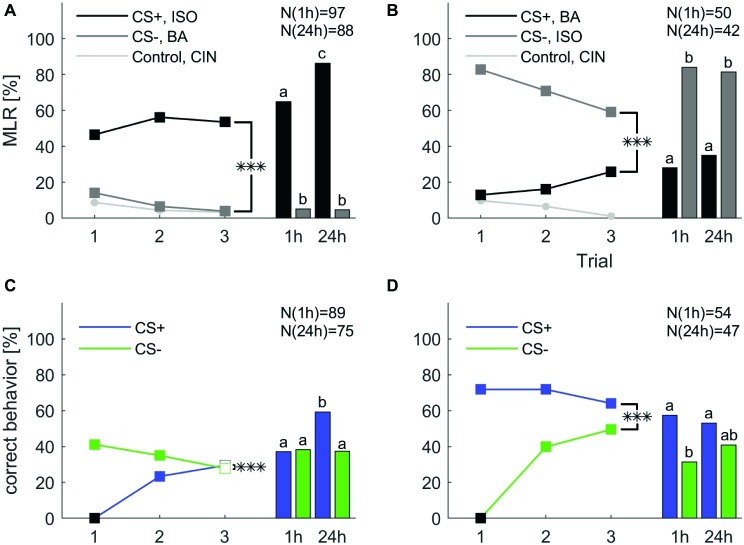
Classical olfactory conditioning over three trials with memory retention tests after 1 and 24 h. Filled squares indicate trials in which a significant difference was found between CS+ and CS− (χ2 test). Asterisks indicate a significant treatment × trial interaction (***: p < 0.001). Letters above the bars indicate significant differences between retention tests (χ2). (A) When isoamyl acetate (ISO) was rewarded (CS+, black) and butyric acid (BA) punished (CS−, dark gray), responses significantly decreased for the CS− (one-way ANOVA: p < 0.001), but did not change for the CS+ (one-way ANOVA: p = 0.155). Overall, the odor × trial interaction was significant (two-way repeated measures ANOVA: p < 0.001). (B) When butyric acid was rewarded (CS+, black) and isoamyl acetate was punished (CS−, dark gray), responses to the CS+ increased, however, not significantly (one-way ANOVA: p = 0.06), but decreased significantly for the CS− (one-way ANOVA: p = 0.002). The odor × trial interaction was again significant (two-way repeated measures ANOVA: p < 0.001). (C) When excluding all spontaneous responding animals to the rewarded odor the response to CS+ increased significantly (one-way ANOVA: p < 0.001). The response to CS− decreased significantly over trials (one-way ANOVA: p = 0.029). The treatment × trial interaction was significant (two-way repeated measures ANOVA: p < 0.001). (D) When excluding all not spontaneous responding animals to the punished odor the number of animals that behaved correctly to CS− over trials increased significantly (one-way ANOVA: p < 0.001). The response to CS+ did not change significantly over trials (one-way ANOVA: p = 0.38). The treatment × trial interaction was significant (two-way repeated measures ANOVA: p < 0.001). Black square in (C,D) indicate the exclusion of animals that did not behave correctly in the first trial.